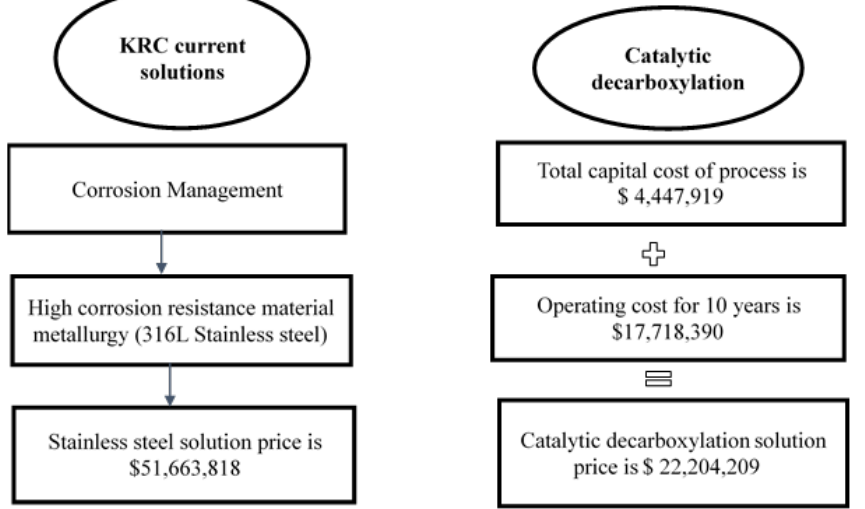
Figure 9. Comparison between KRC current corrosion solutions and catalytic decarboxylation process cost .